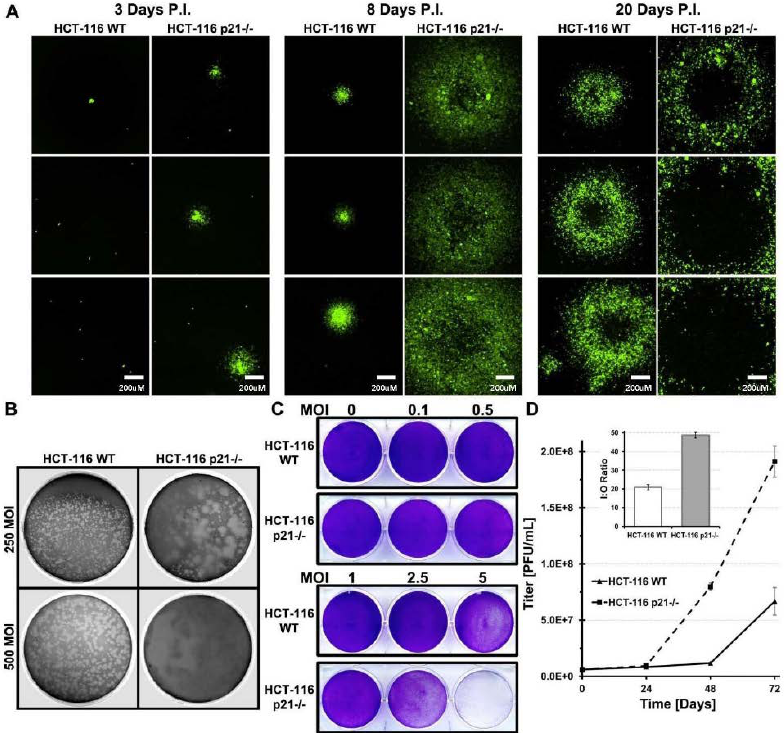
Figure 4. Viral burst size is significantly larger in HCT-116 p21 −/− cells. HCT-116 WT and p21 −/− cells were plated in 10-cm dishes and infected with 250 or 500 PFU of AdTrack-HisE1A-E1B virus. After 1 h, virus was removed and overlaid with 0.1% Agarose Media mixture. GFP fluorescence was imaged at indicated time points to follow viral burst ( A ). HCT-116 WT and p21 −/− cells were plated in 10-cm dishes and infected with 250 or 500 PFU of CN702 virus. After 1 h, virus was removed and overlaid with 0.1% Agarose Media mixture. 26 days p.i. overlays were stained with neutral red overnight ( B ). HCT-116 WT and p21 −/− cells were infected with various MOI of CN702. At 72 h, p.i. cell monolayers were stained with 0.5% crystal violet in methanol to visualize viral CPE ( C ). Assessing infectious particle titer over time. HCT-116 WT and p21 −/− cells were plated in 6 well plates and infected with 10 MOI of CN702. Cells and media were harvested at indicated time points and viral titer was done on 293 HEK cells ( D ). Statistical significance was defined as * p ≤ 0.05.